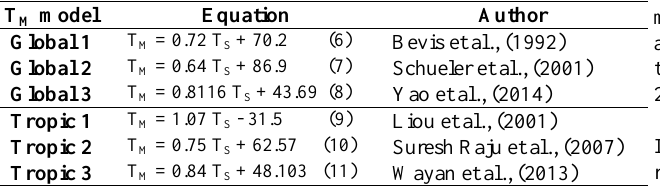
Table 1. The existing T M model with the